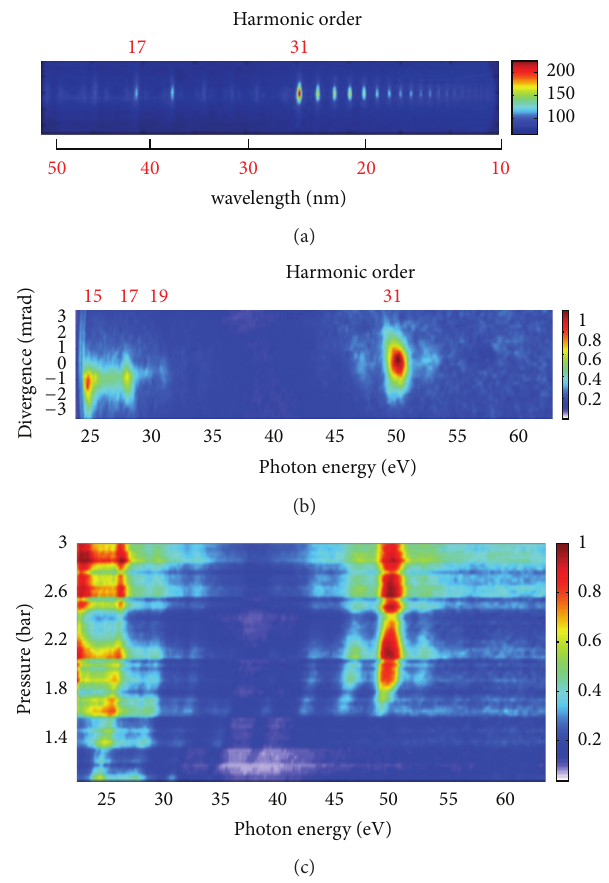
Figure12:Rawimagesofharmonicspectrafrommanganeseplasma inthecaseof(a)40 fsand(b)3.5 fsprobepulsesobtainedatthesame intensity. (c) Raw images of harmonic spectra from Mn plasma at different pressures of neon in the hollow fiber obtained at the same energy of probe laser pulses